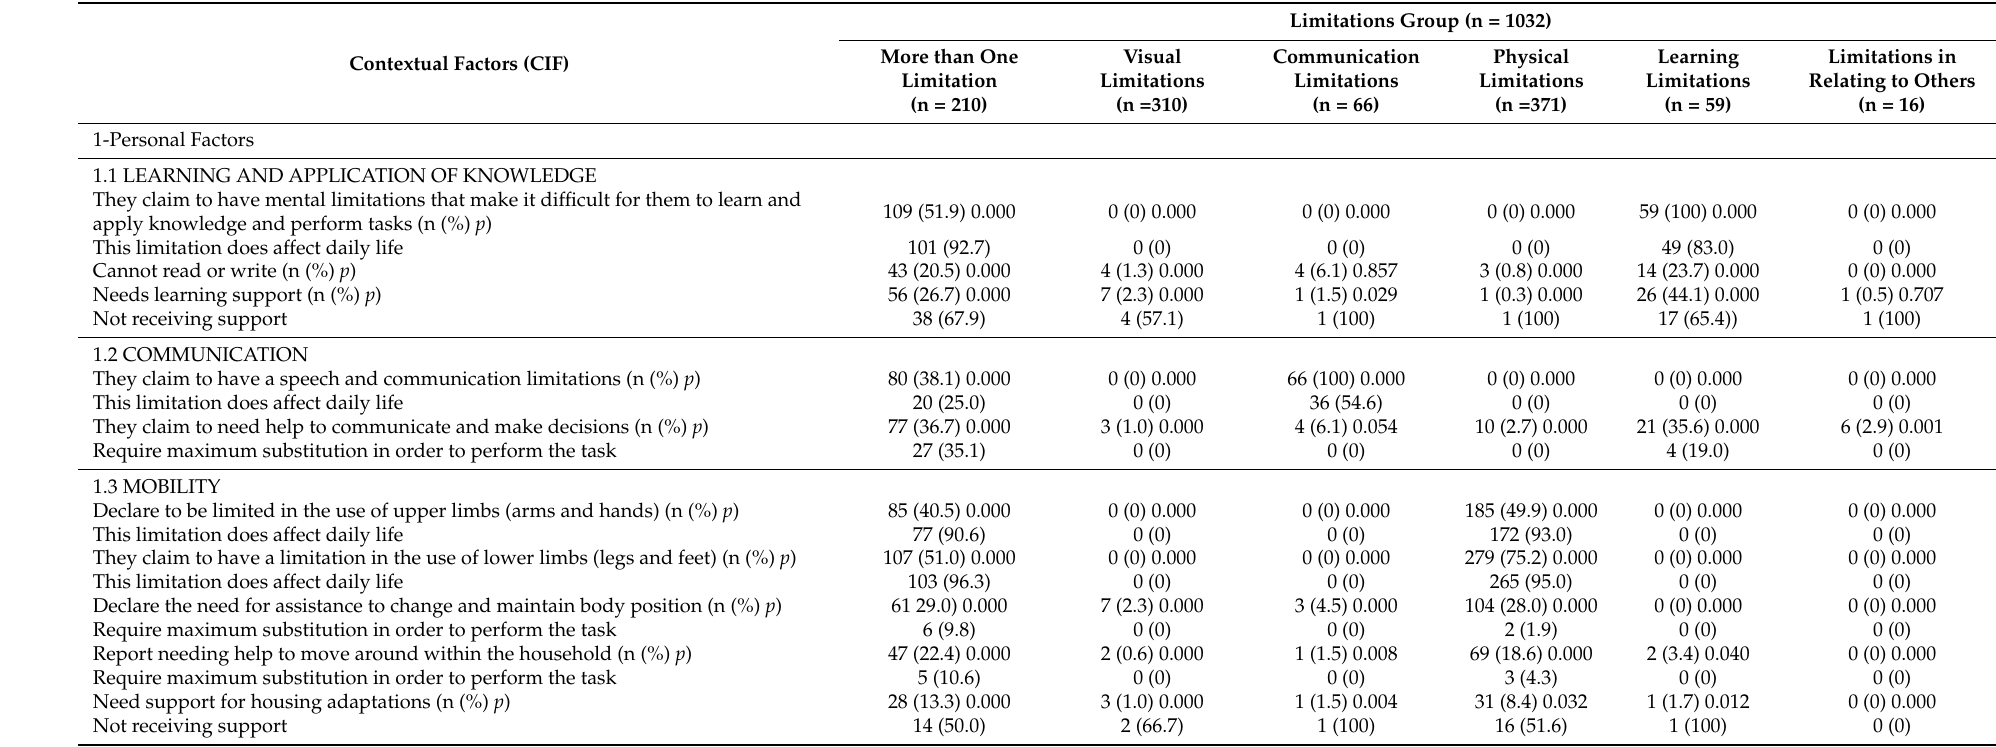
Table A1. Contextual Factors described through the ELPS variables, by the type of